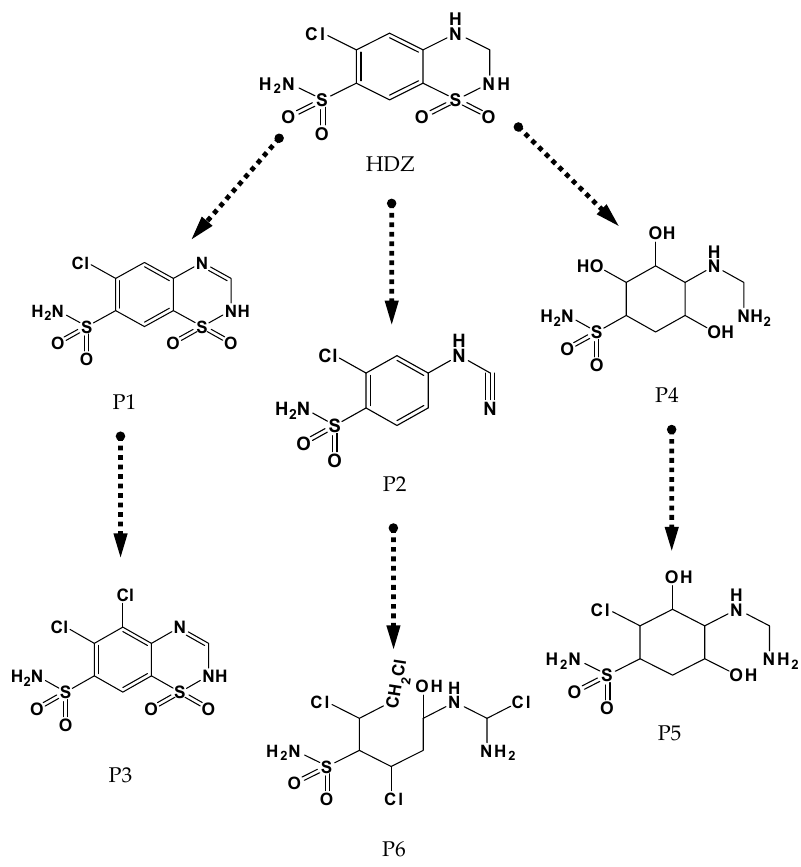
Scheme 1. Proposed pathway degradation of the by ‐ product.